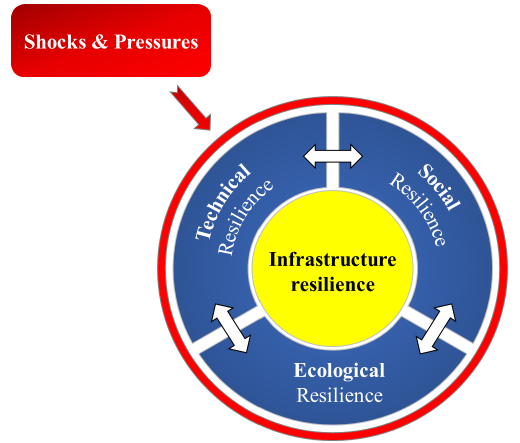
Figure 1. Conceptual framework showing that the resilience of in- frastructure systems to shocks and pressures depends on the re- silience of the interlinked social, ecological, and technical sub- systems.